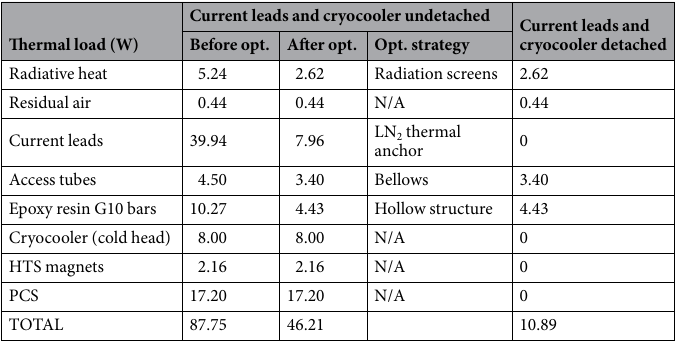
Table 3. Estimated heat loads on the HTS magnets system and corresponding optimization